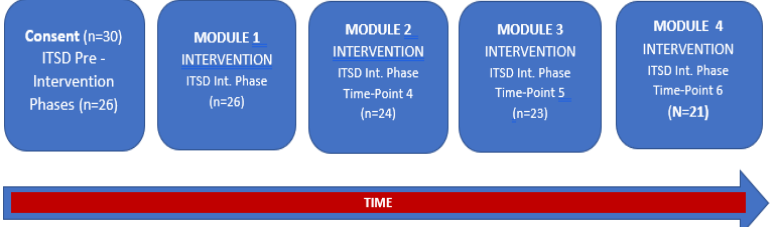
Figure 1. Study flow diagram. Note : ITSD stands for interrupted time series design; Int. stands for intervention. Participants were provided 2 weeks to complete each module once it was started on Canvas.